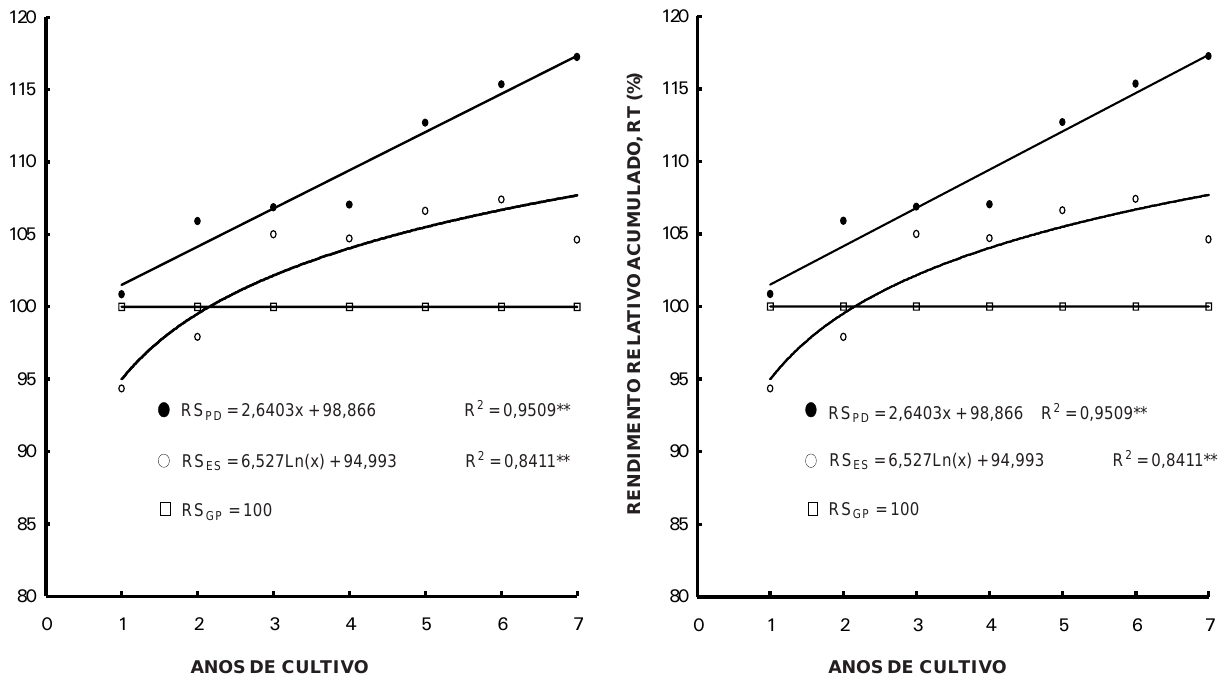
Figura 3. Rendimentos relativos acumulados de grãos de trigo (RT) em plantio direto (PD) e com escarificação + gradagem niveladora (ES), considerando os sistemas de preparo com gradagens pesada + niveladora (GP), em função do tempo de